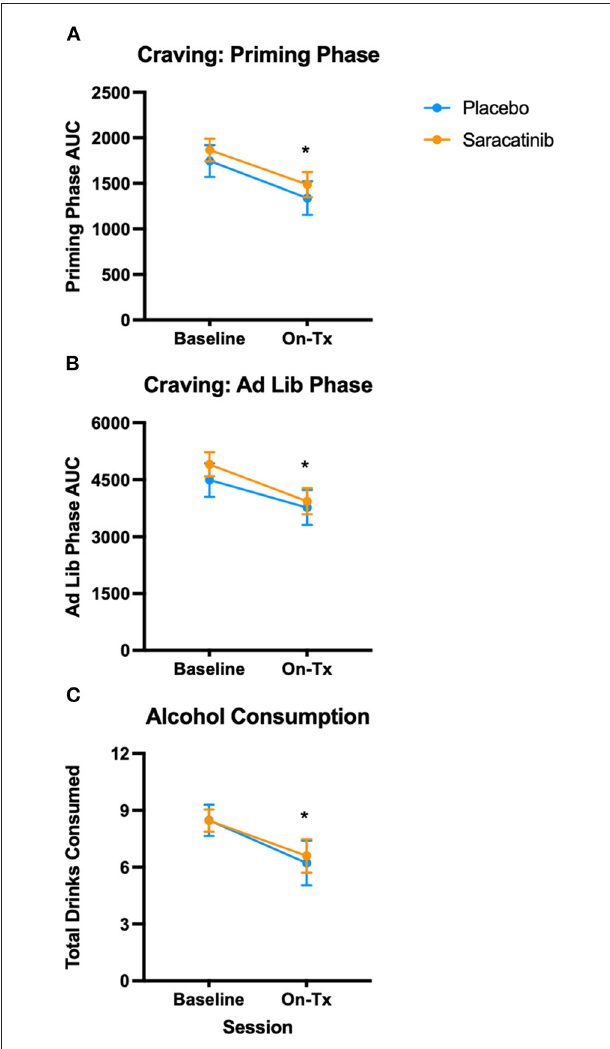
FIGURE 2 | 125 mg/day saracatinib did not affect alcohol craving or consumption in human participants. Participants underwent two ADPs: One prior to initiating treatment (“Baseline”) and a second one following 7–8 days of 125 mg/day oral saracatinib treatment (“On-Tx”). (A) AUC for craving during the priming phase of the ADP session. (B) AUC for craving during the ad libitum phase. (C) Total drinks consumed. N = 15 placebo; n = 26 saracatinib. * p < 0.05 vs. baseline ADP across groups (main effect of session). ADP, alcohol drinking paradigm; AUC, area under the curve; Tx,